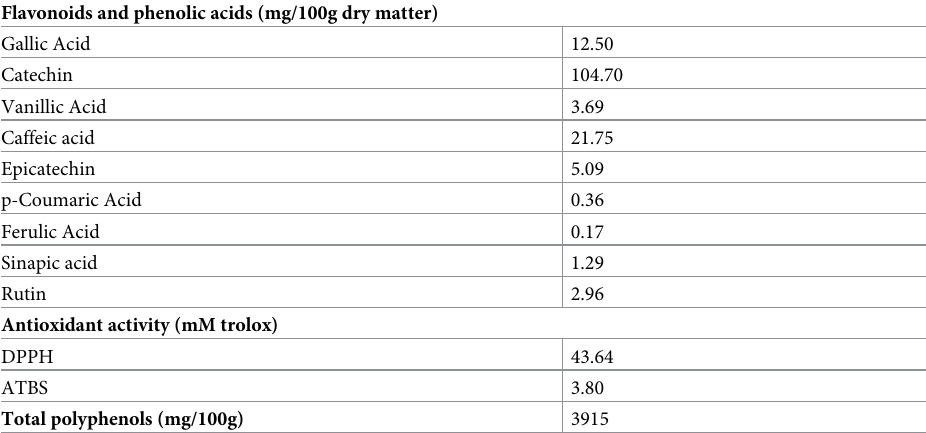
Table 1. Composition and antioxidant activity of GSM extract.